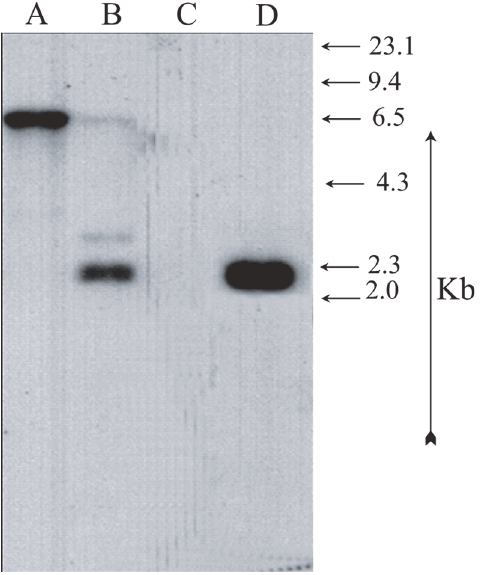
Figure 3. Southern hybridization analysis of total genomic DNA of P. putida NBRI1108 and NBRI1108T. (A) Eco RI digested NBRI1108T (B) Xho I digested NBRI1108T (C) Eco RI digested NBRI1108 and (D) E . coli WA803 ⁄ pGS9 DNA as positive control for the 32 P-labelled Tn5 probe as described in materials and methods. Molecular size values in the margins are in